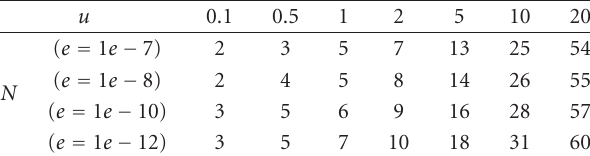
Table 1: Number of terms to truncated error for di ff erent u